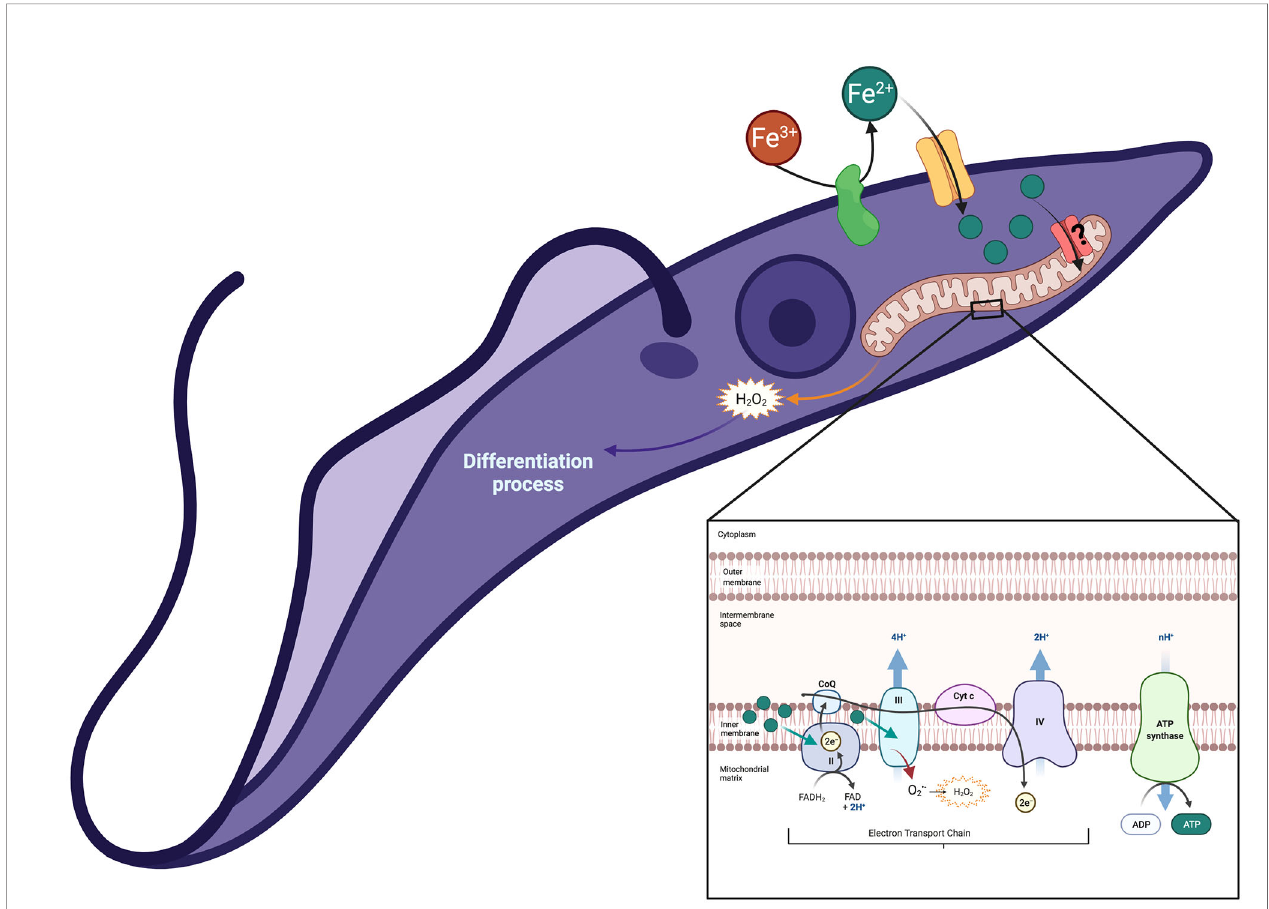
FIGURE 7 | Proposed model of functional coupling between TcFR and TcIT in the plasma membrane of T. cruzi , which allows Fe 3+ reduction, Fe 2+ uptake, its delivery to the cytosol, and through reaching the mitochondria either via an unknown iron transporter present in the inner mitochondrial membrane or bound to a carrier protein or metalloprotein. Once in the mitochondria, Fe 2+ stimulates H 2 O 2 formation from an excess of the substrate O · − 2 , and differentiation to trypomastigote forms, as depicted in the ampli fi ed graphical insert of a mitochondrial structure. Green fi lled circles represent Fe 2+ ions entering the mitochondrial matrix via internalized TcIT molecules that could insert in the mitochondrial internal membrane after their cycling into the cytosol. H 2 O 2 -induced mitochondrial remodeling could be responsible for the activation of differentiation, as recently proposed for other scenarios where epimastigotes differentiate into trypomastigotes (Pedra-Rezende et al., 2021). Created with